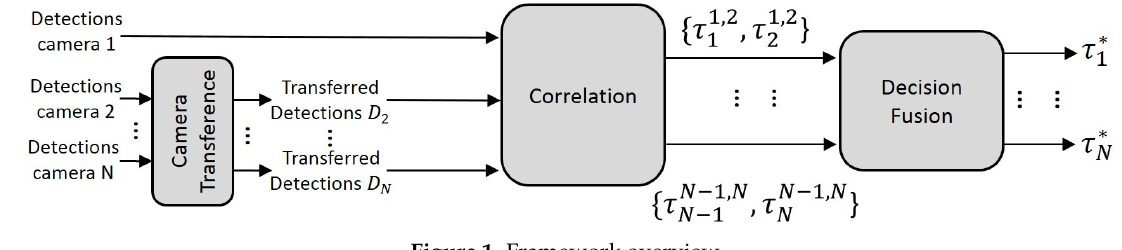
Figure 1. Framework